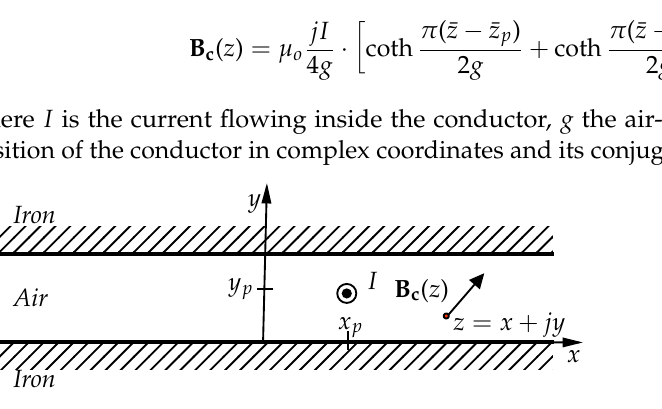
Figure 1. Conductor powered by a current I , flowing outwards from the paper plane between two smooth infinitely permeable iron surfaces in the complex plane.